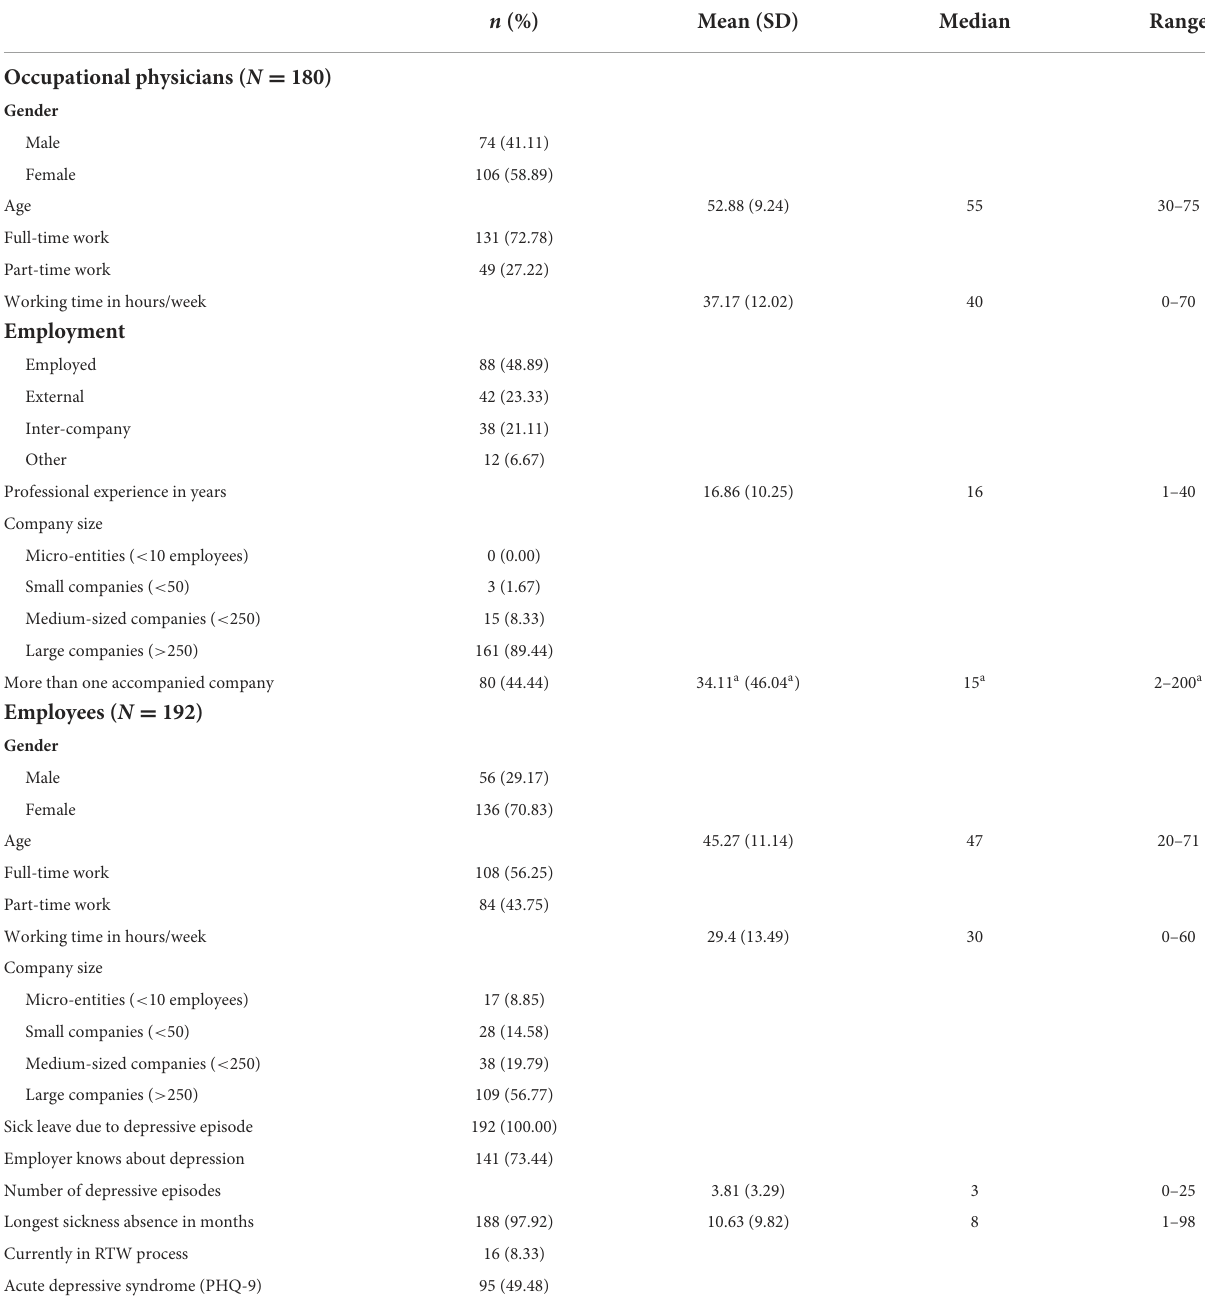
TABLE 1 Description of study